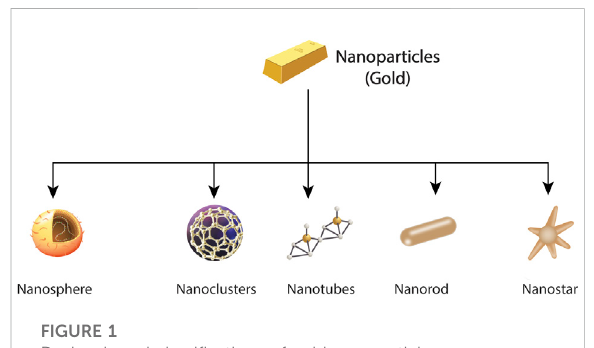
FIGURE 1 Design-based classi fi cations of gold nanoparticles.